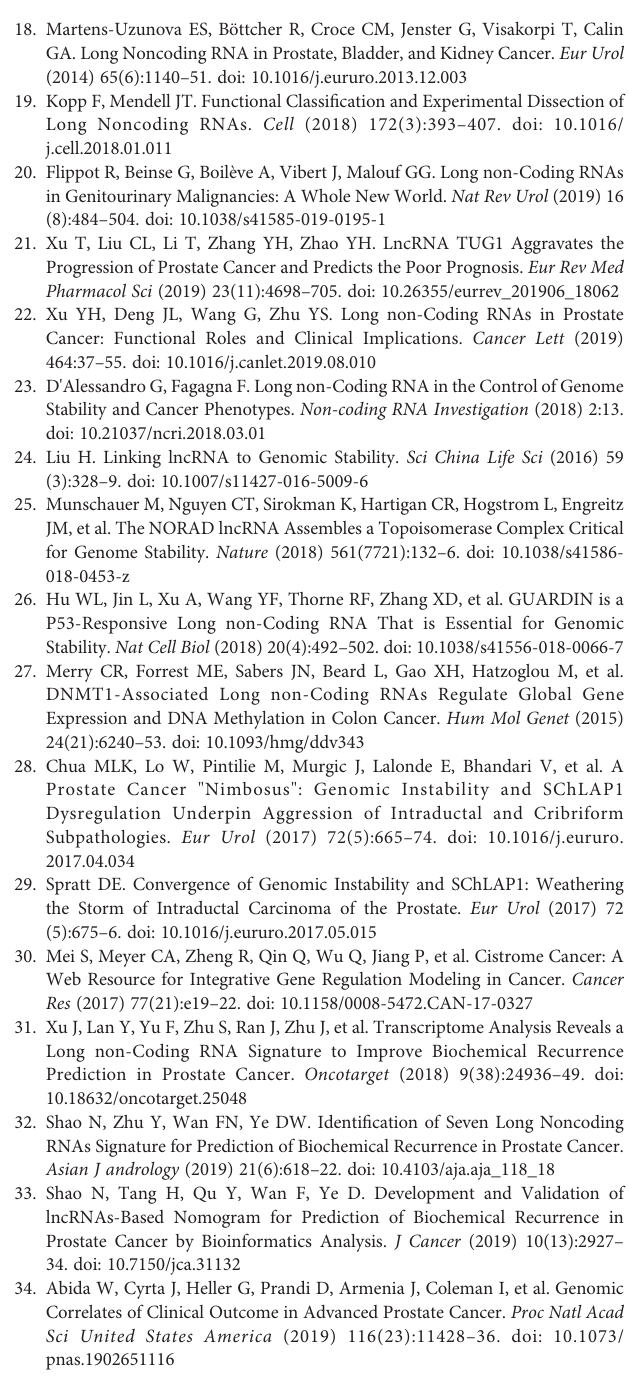
Supplementary Figure 3 | SPOP and TMPRSS2 expression in two GILncSig groups. (A, B) The train set. (C, D) The test set. (E, F) The TCGA set. Supplementary Figure 4 | (A) ROC curves analysis of the GILncSig in the test set. (B) ROC curves analysis of the GILncSig in the whole TCGA set. Supplementary Figure 5 | A transcription factors-lncRNAs regulatory network. Constructed a regulatory network of lncRNAs with prognostic value.